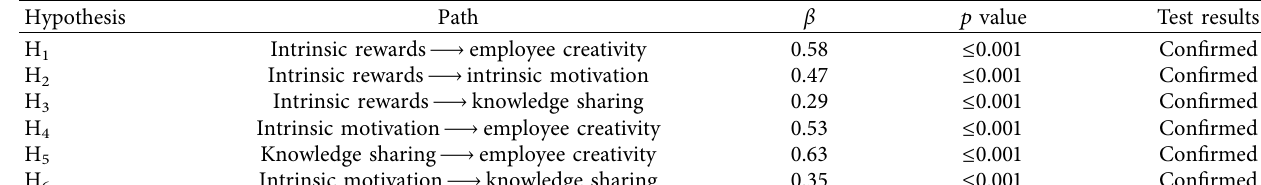
Table 4: The results of direct hypothesis testing.